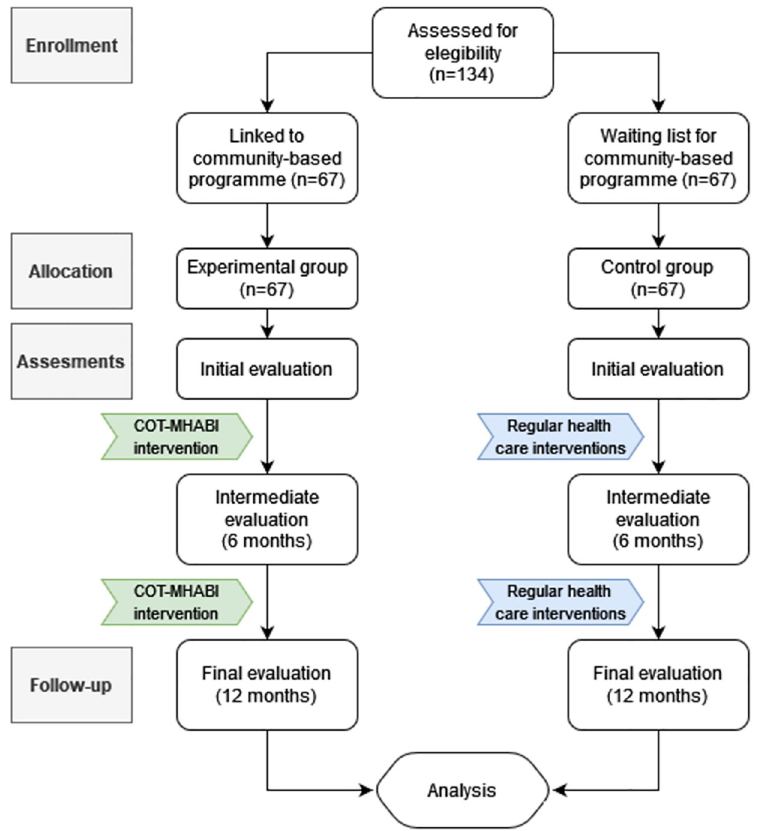
Fig 2. Study methods flow chart. 134 participants will be assessed for elegibility, allocating 67 in each arm (experimental and control groups). COT-MHABI protocol will be applied in experimental group and regular health care interventions in control group. For both groups, outcomes will be assessed over a one-year period at baseline, by the 6 th and 12 th month, when data collection is closed and analysis begins.